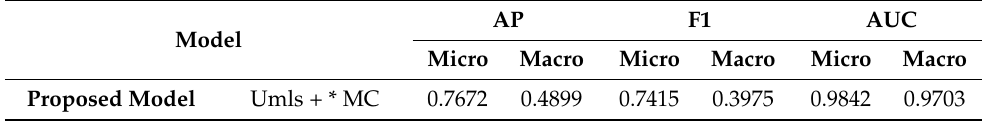
Table 6. Test performance of Proposed